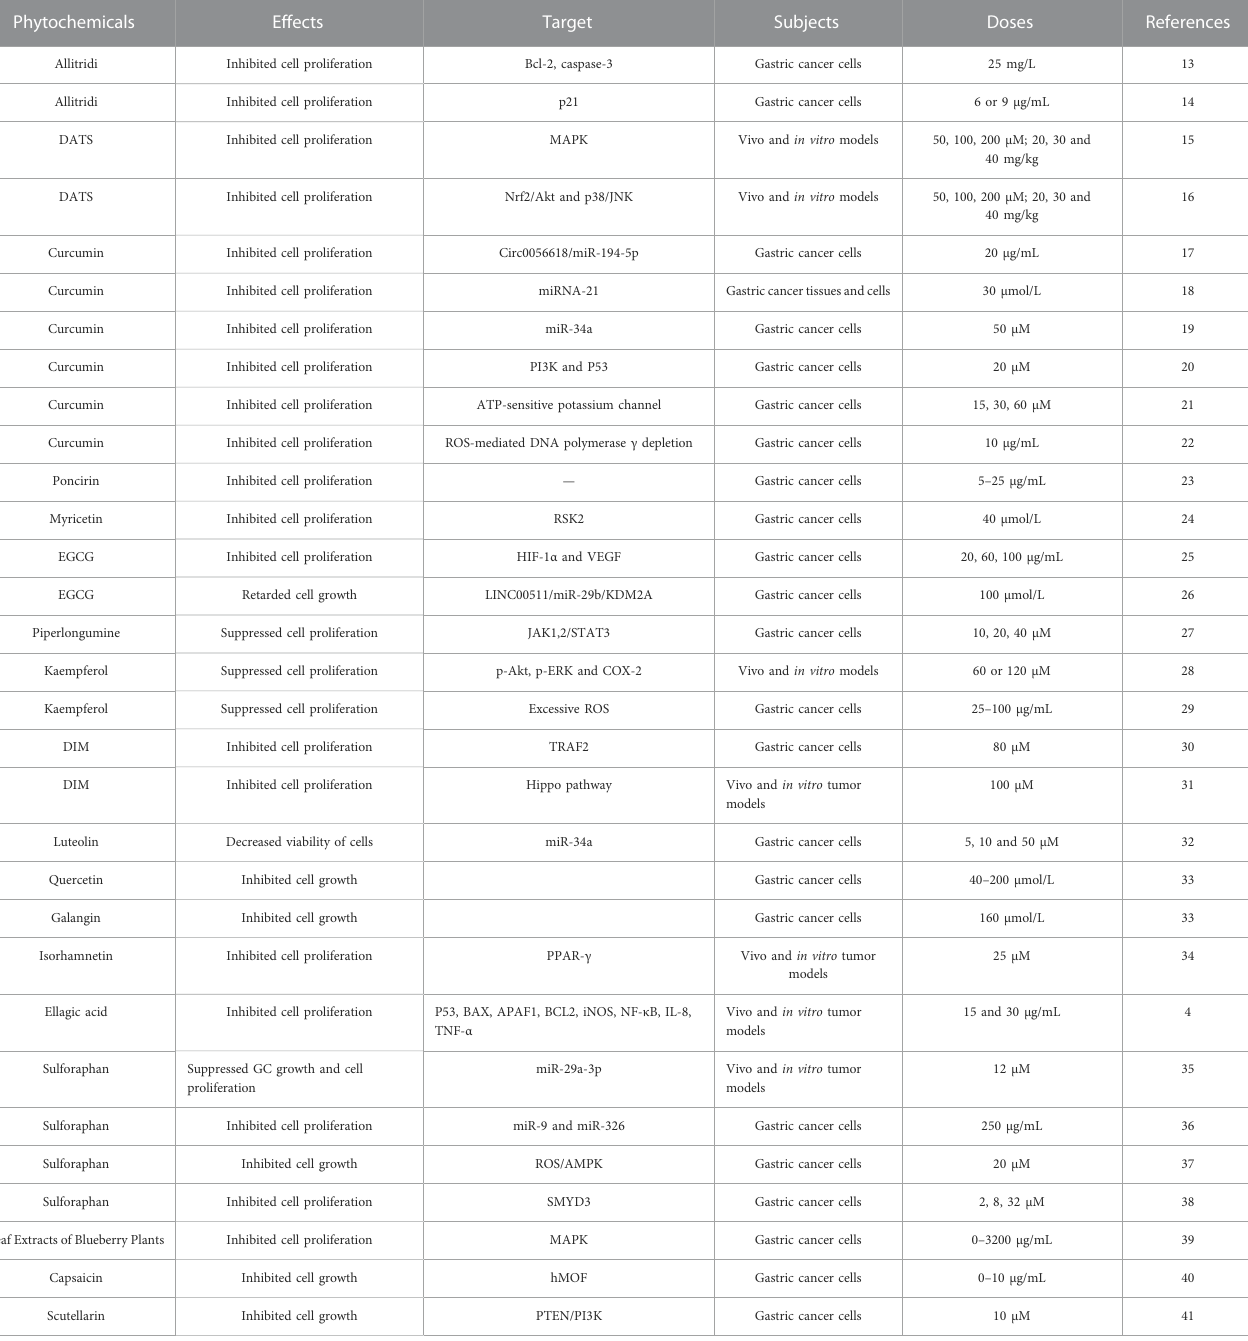
TABLE 1 Overview of the role of phytochemicals in the proliferation of gastric cancer. Phytochemicals